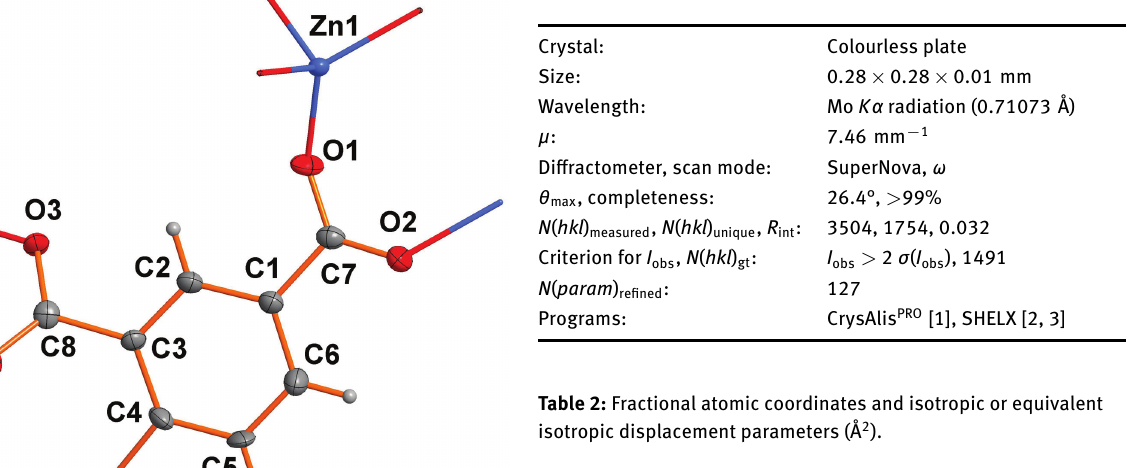
Table 1: Data collection and handling.